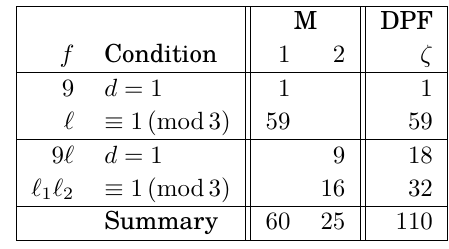
Table 12: Cyclic cubic discriminants d L = f 2 in the range 0 < d L < 5 · 10 5